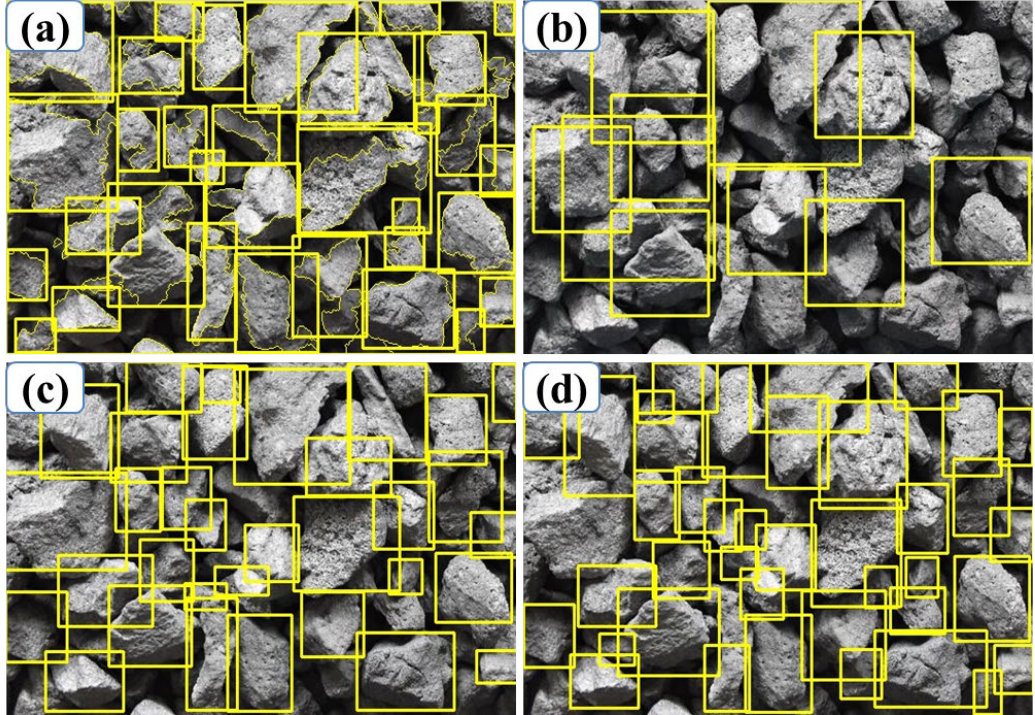
Figure 10. Image detection results of coke particles. ( a ) MW; ( b ) HOG + SVM; ( c ) Faster R-CNN; ( d ) YOLOv3.